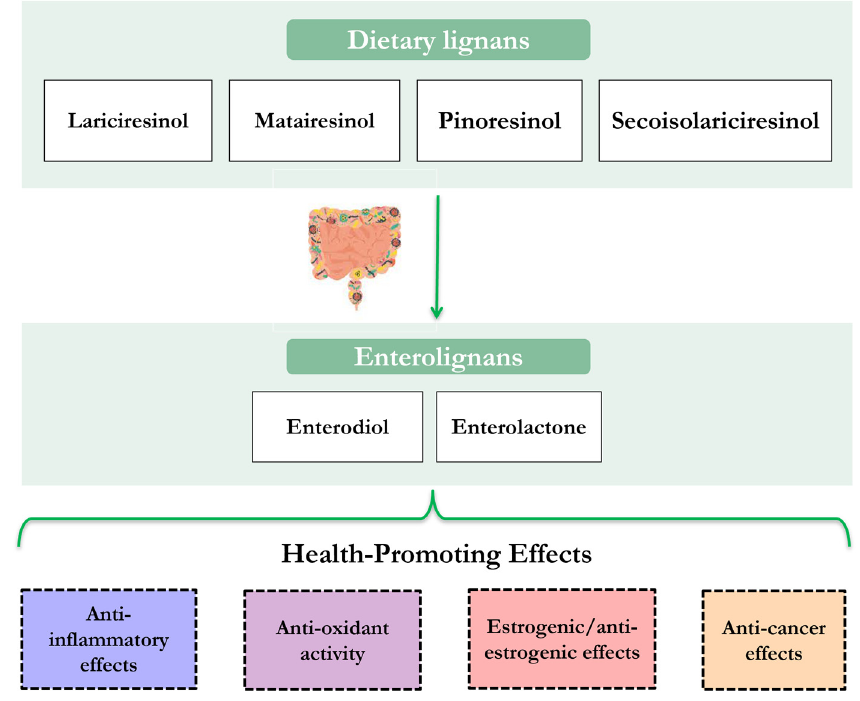
Figure 2. Main health-promoting proprieties of microbial-derived enterolignans.